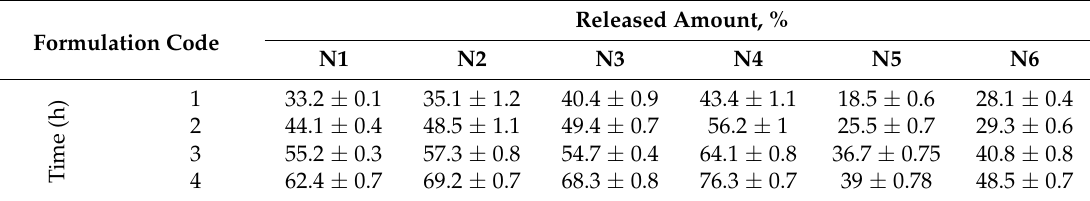
Table 2. Amorolfine hydrochloride release (%) from experimental